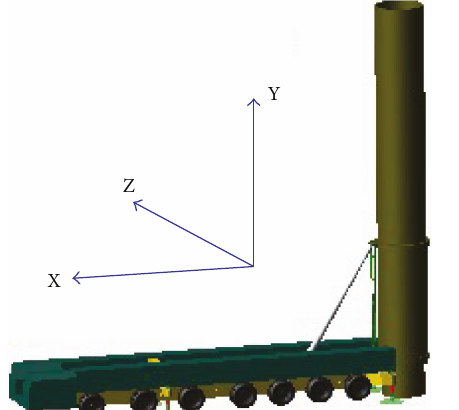
Figure 7: Launching dynamic model of vehicular missile weapon system.